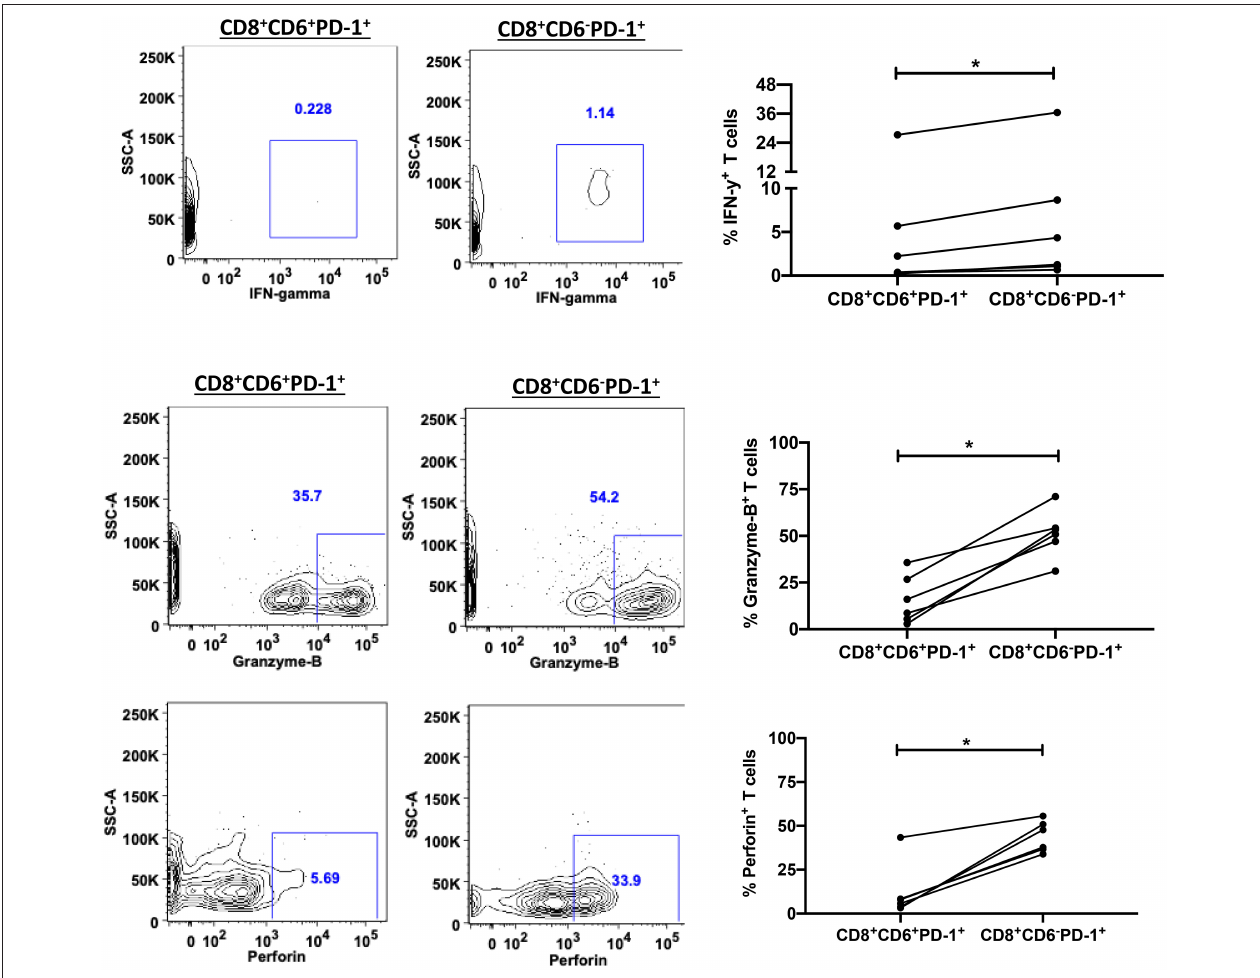
FIGURE 7 | Overexpression of CD6 and PD-1 impairs CD8 + T cell antiviral activity. Representative staining and the frequency of splenic CD6 + PD-1 + and CD6 − PD-1 + CD8 + T-cells expressing IFN- γ (Top), granzyme B (Middle) and perforin (bottom) in vivo . Data are from 6 macaques. Data are shown as means ± SEM. For statistical analysis, Mann-Whitney tests were performed. * p <